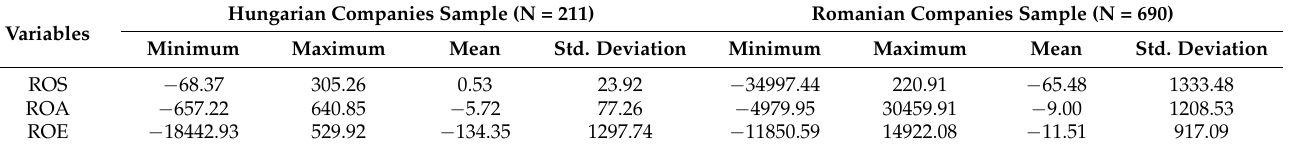
Table 2. Descriptive statistics of samples.